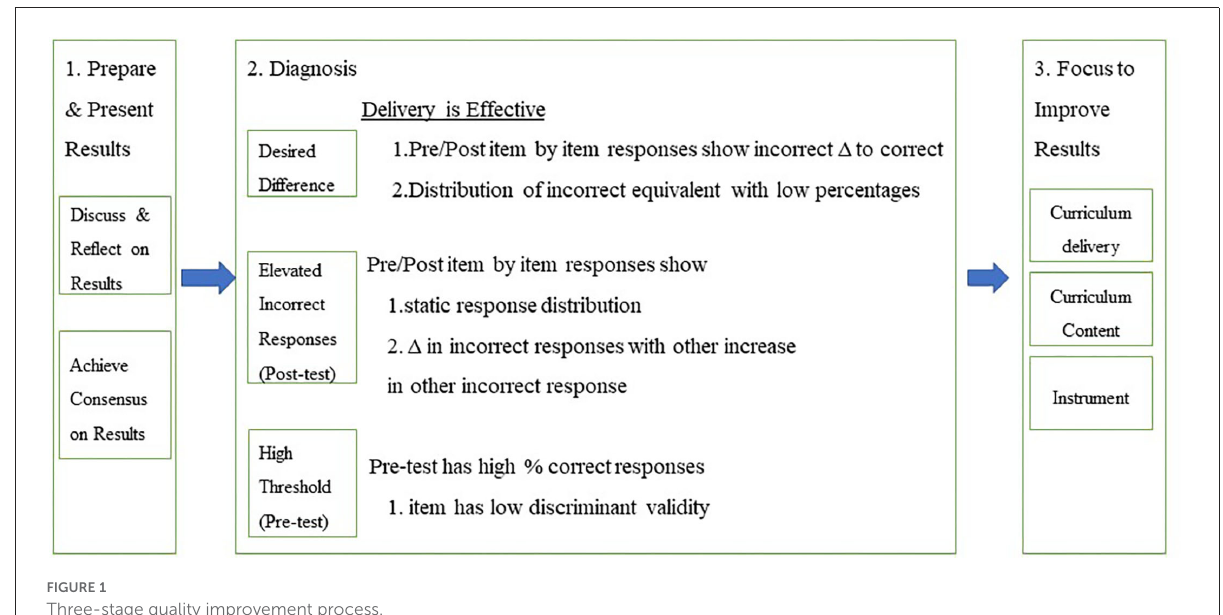
FIGURE1 Three-stage quality improvement